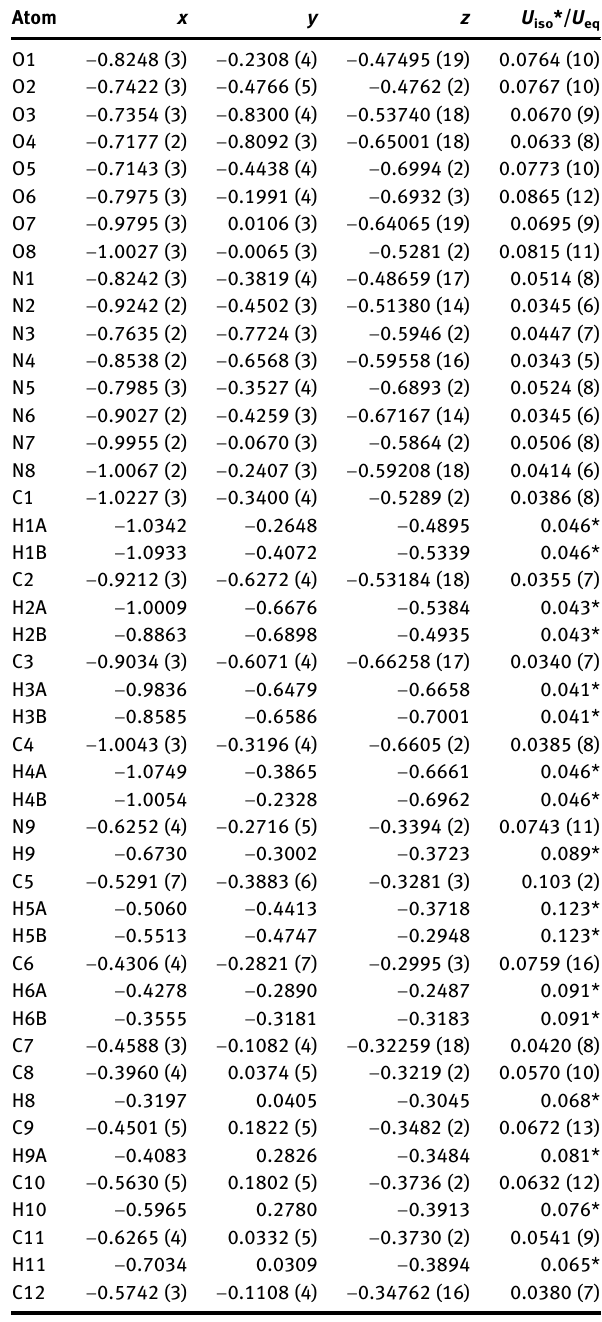
Table  : Fractional atomic coordinates and isotropic or equivalent isotropic displacement parameters (Å 